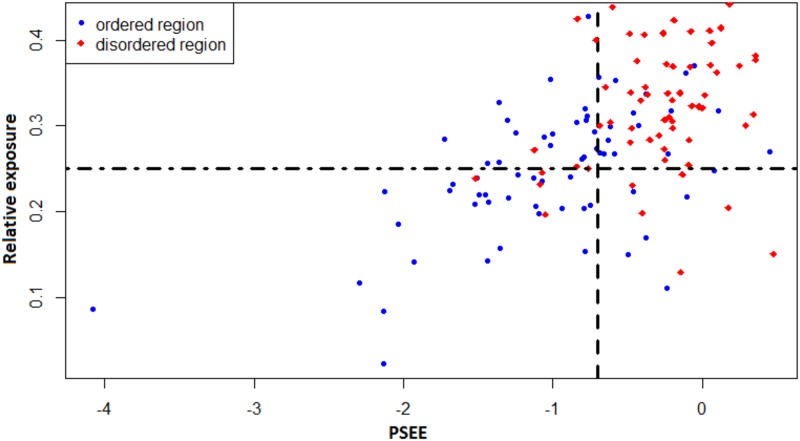
Correlation between PSEE and relative exposure of ordered and disordered regions.PSEE and relative exposure of ordered regions are shown by blue circles and those of disordered regions are shown by red diamonds. The vertical dashed line separates the average PSEE of ordered and disordered regions and the horizontal dash-dotted line separates the ordered and disordered regions with more and less 25% exposure.